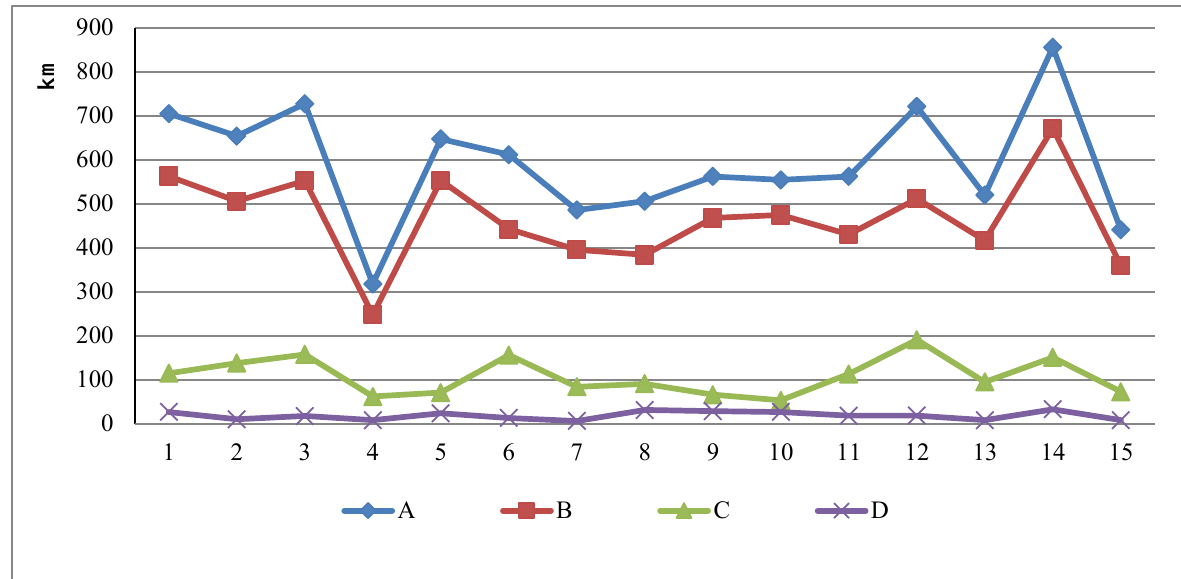
Fig.1. Distribution of differently oriented run loads’ partial volumes in annual training macro